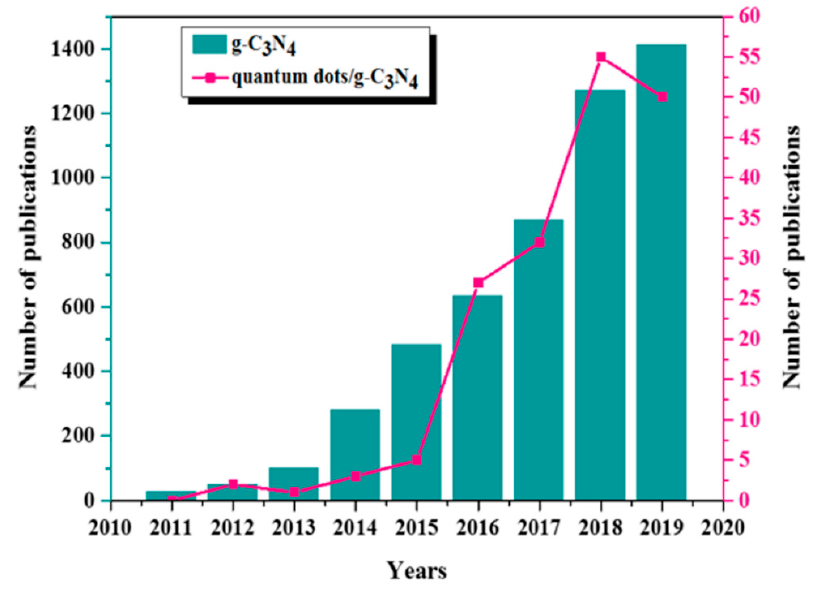
Figure 2. Number of publications of g-C 3 N 4 -related papers in terms of the keywords: “g-C 3 N 4 ,” “graphitic carbon nitride,” and quantum dots/g-C 3 N 4 -related papers in terms of the keywords: “g-C 3 N 4 ,” “graphitic carbon nitride,” “quantum dots,” “CQDs,” and “GQDs”. Data refers to indexed journal publications between 2011 and 2019, as reported on “Web of Science.”